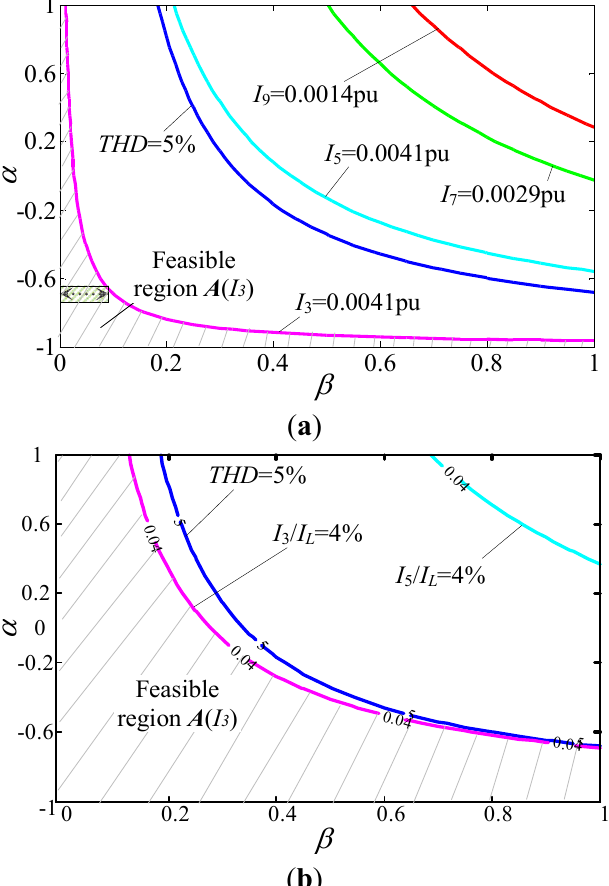
Figure 4. The contour lines of odd current harmonics and current THD: ( a ) Feasible region based on “Q/GDW617-2011” and ( b ) Feasible region based on “IEEE Std.